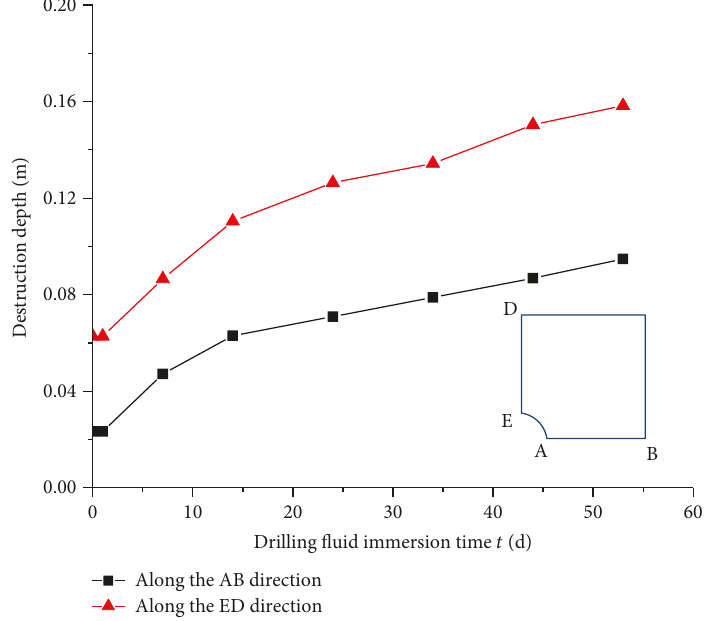
Figure 16: Failure depth change of the wellbore when the drilling fl uid density is 1.1.